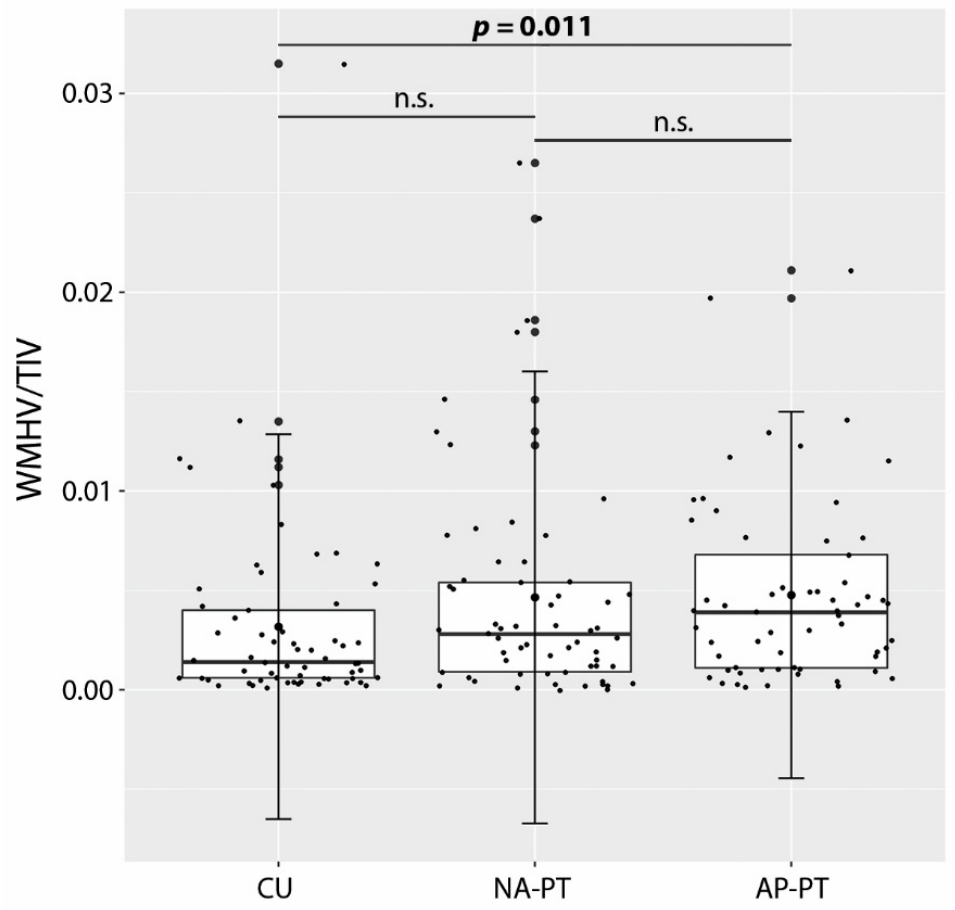
Figure 1. Differences in relative WM hyperintensity volume (WMHV/TIV) across groups (error bars are standard deviations). AP-PT: Patients with apathy, CU: Cognitively unimpaired, NA-PT: Patients without apathy, TIV: Total intracranial volume, WM: White matter, WMHV: White matter hyperintensity volume.